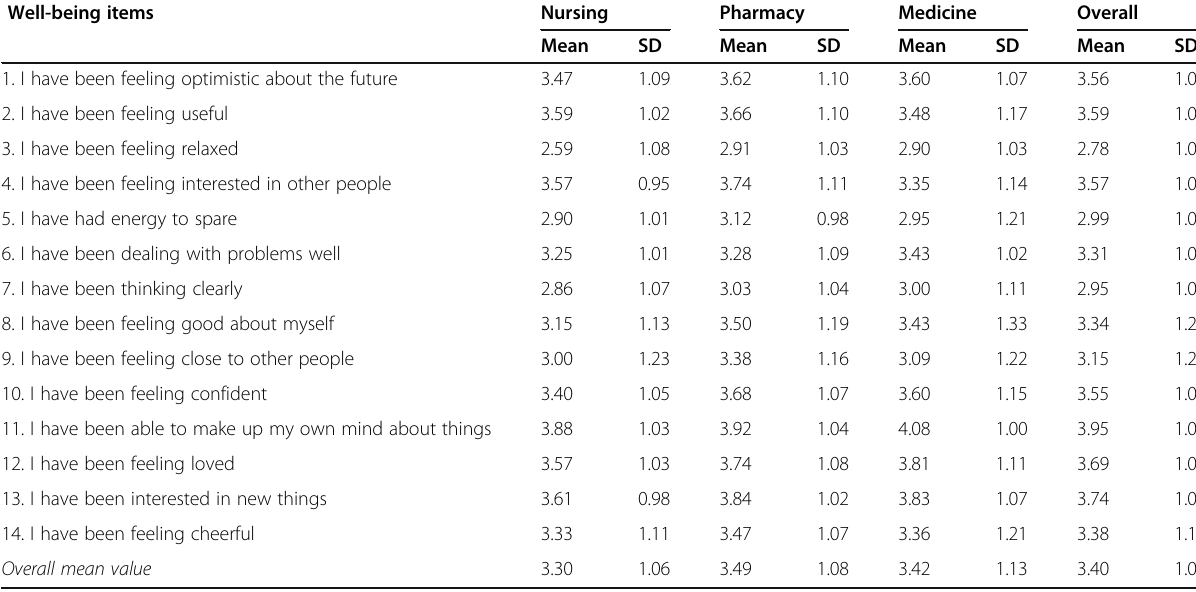
Table 2 Comparison of well-being among students from three different colleges at King Saud University Well-being